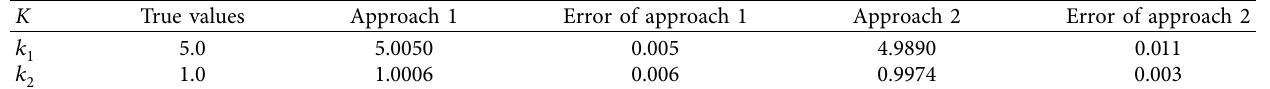
Figure 2: Results of Example 1. (a) Exact solution, ANN, and data. (b) Absolute error. Table 2: Comparison of the two approaches for Example 1.